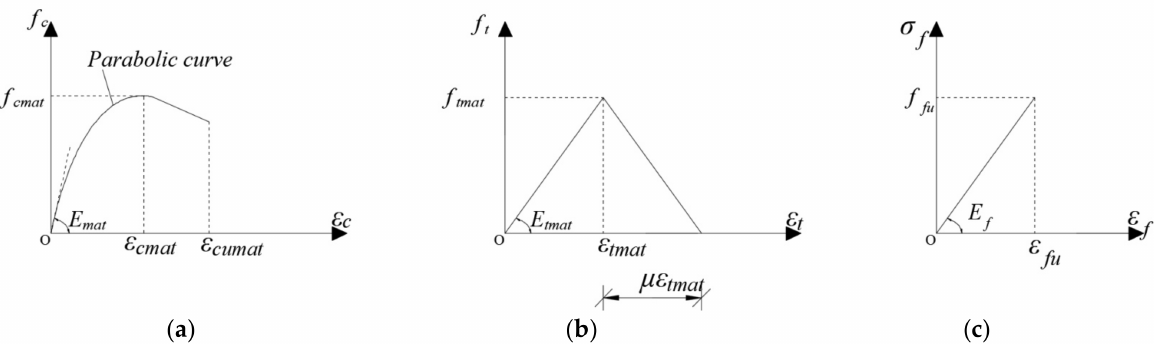
Figure 3. Stress–strain relationship: ( a ) compression, ( b ) tension for the mortar, and ( c ) linear elastic for fabric.